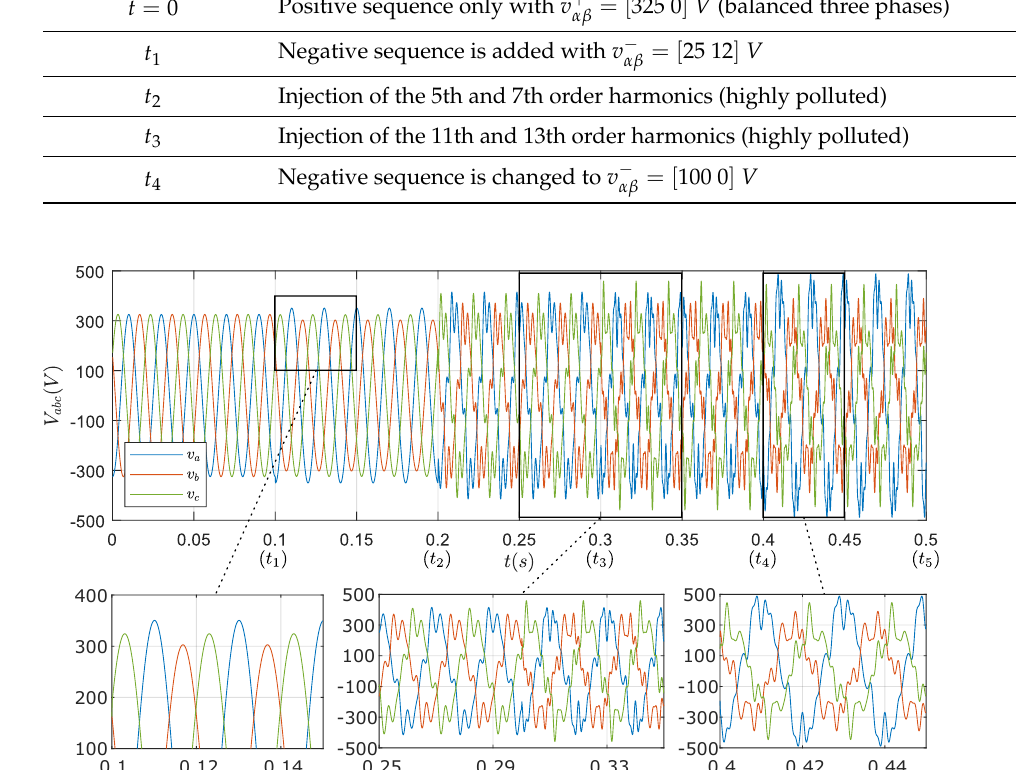
Figure 9. Three-phase voltage and the respective changes introduced during test #1.